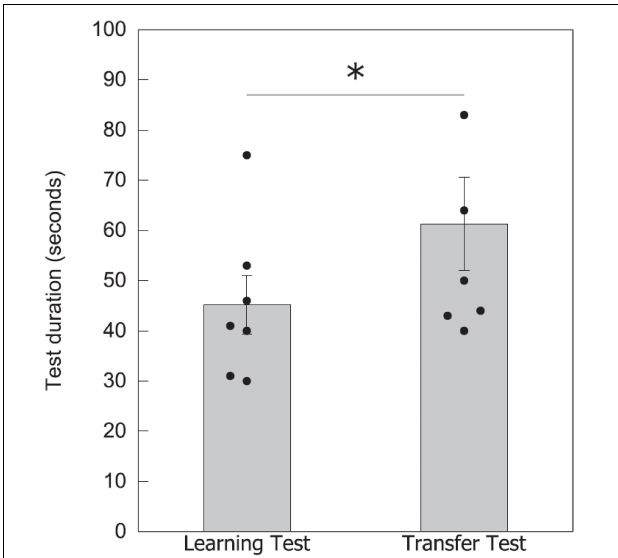
FIGURE 5 | Test duration for completing the learning and transfer tests. Data shown are means ± SEM for the learning and transfer tests. N = 7 bees were recorded for the time taken to complete each test. Black circles show individual data for each bee. Significantly different results are indicated by ∗ ≥ 0.05.